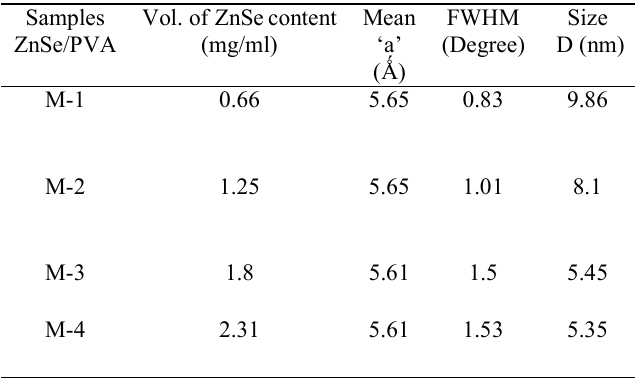
Figure 2: XRD of ZnSe-PVA Nanocomposite films Table 2: XRD Analysis of ZnSe/PVA Nanocomposites (ICSD-II Card no-067791)